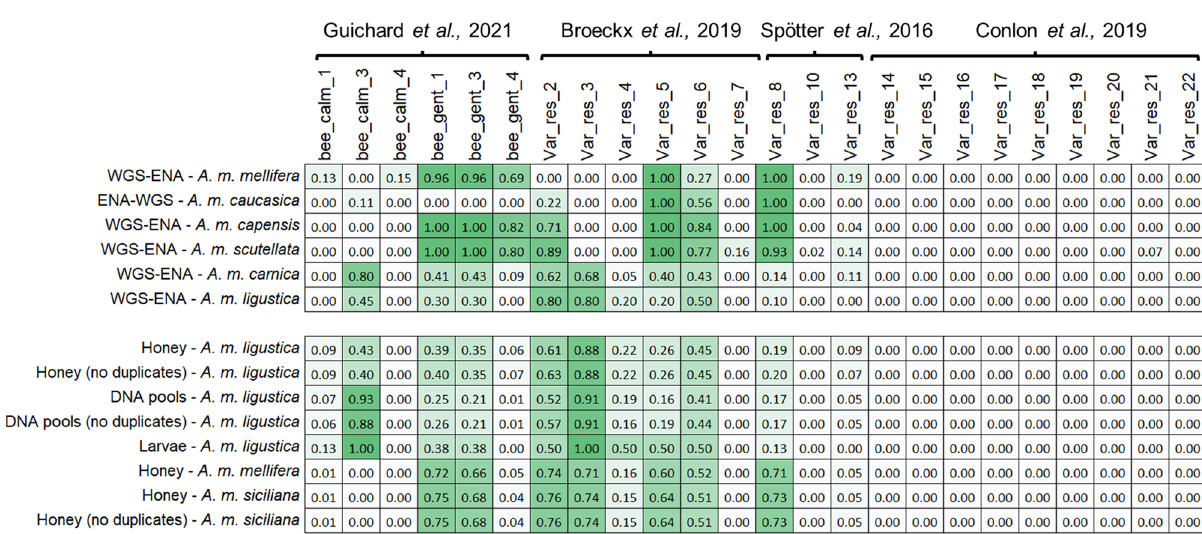
Figure 2. Multidimensional scaling plots (MDS) of the 672 samples combining genotyping by sequencing (GBS) results obtained from specimens analysed in this study and from data retrieved from public sources. The analyses are based on the 97 targeted ancestry informative SNPs. The first two components are presented. Each dot represents a sample. ( A ) Results are from samples and data reported by Henriques et al. 29 . ( B ) Results are from datasets retrieved from ENA. ( C ) Honey, honeycomb and honey bee samples analysed with the described GBS panel. In the background (grey spots), results from the sets A and B.